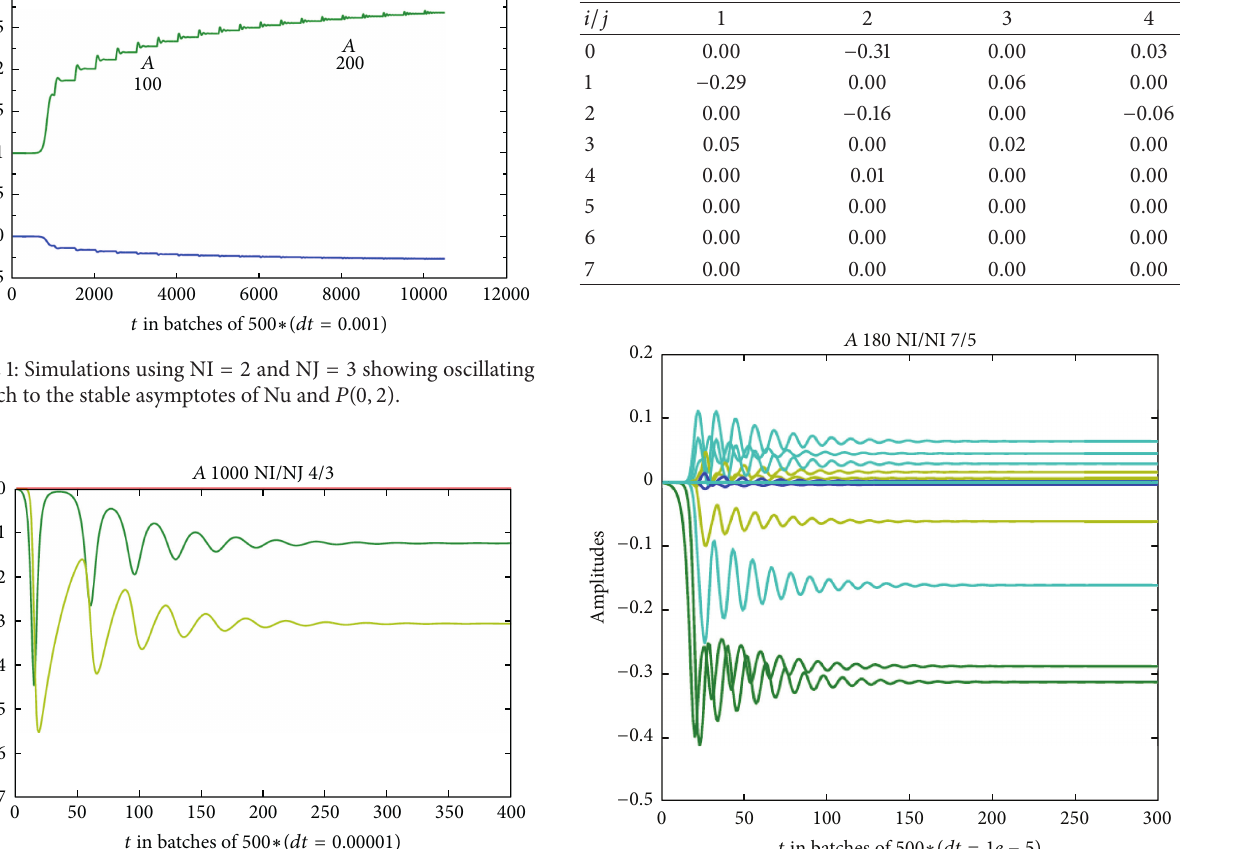
Figure 2: Simulation using NI = 4 and NJ = 3 . 𝑅